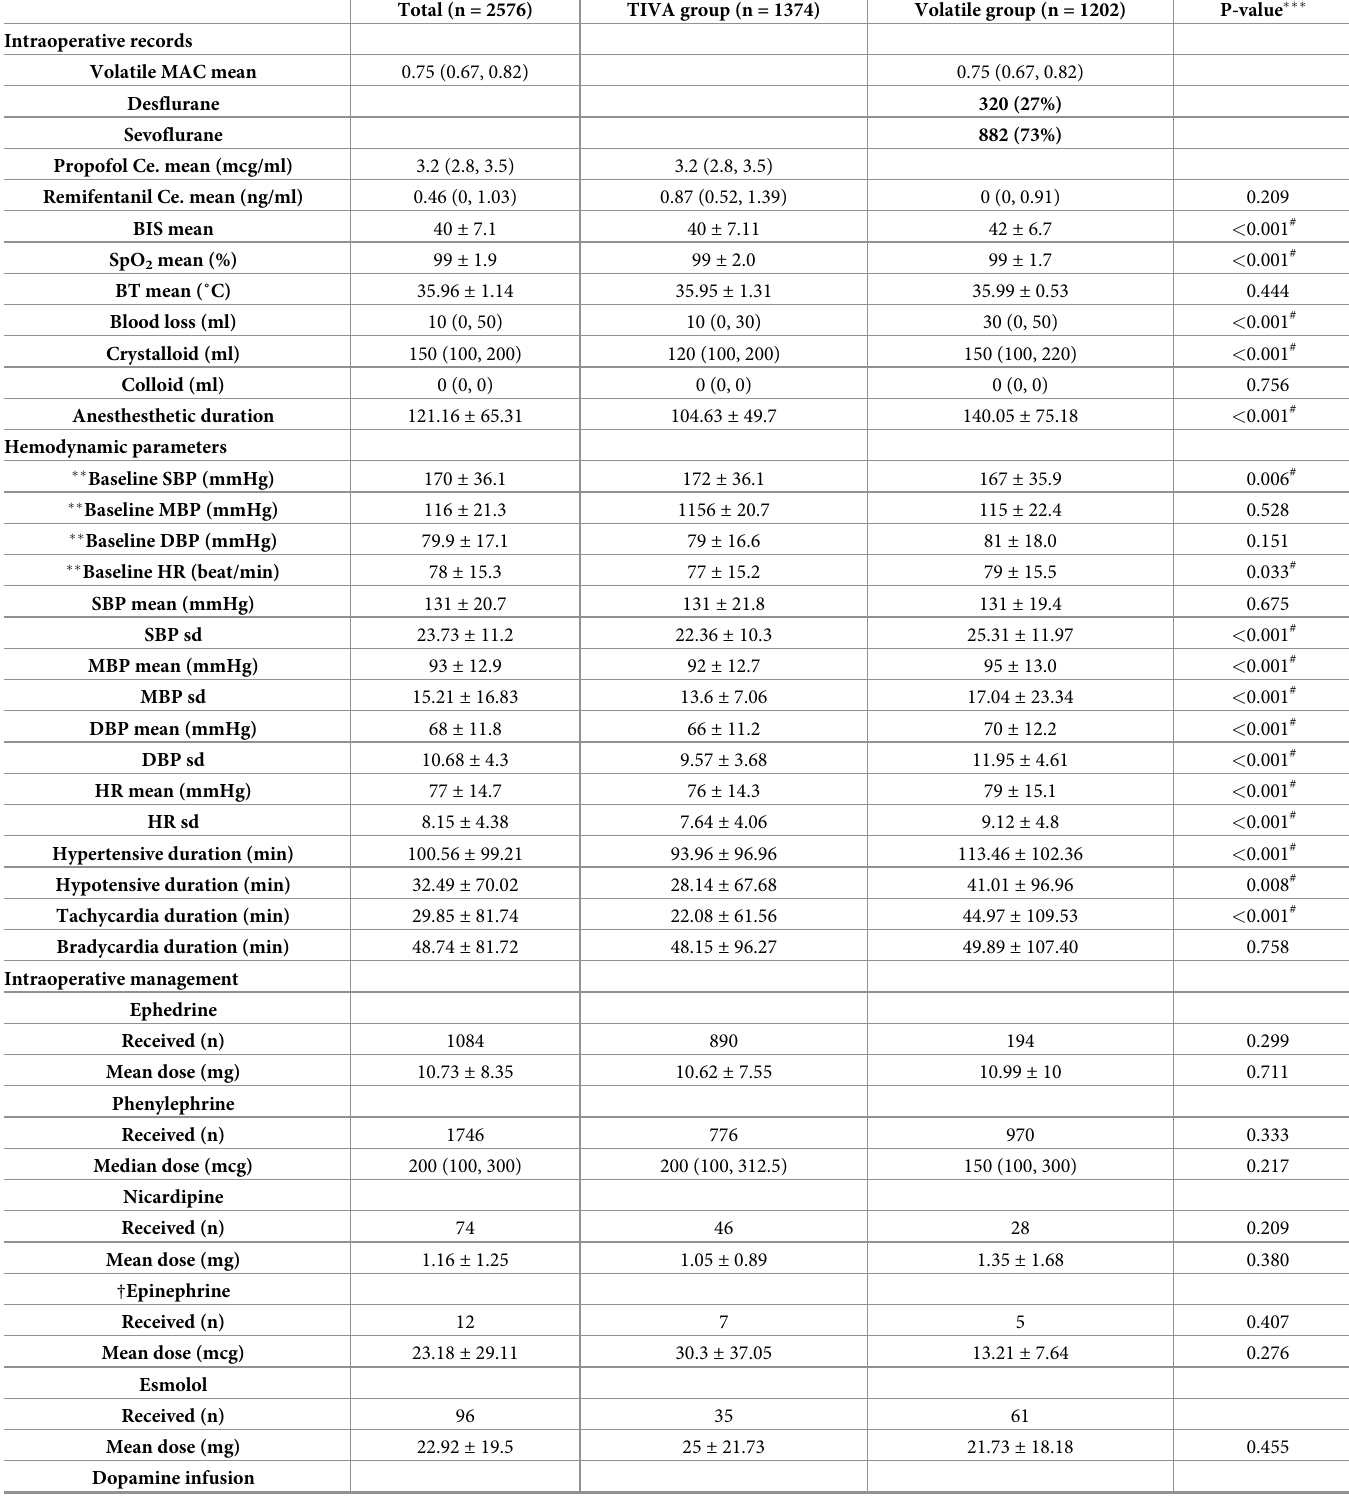
Table 2. Intraoperative records and